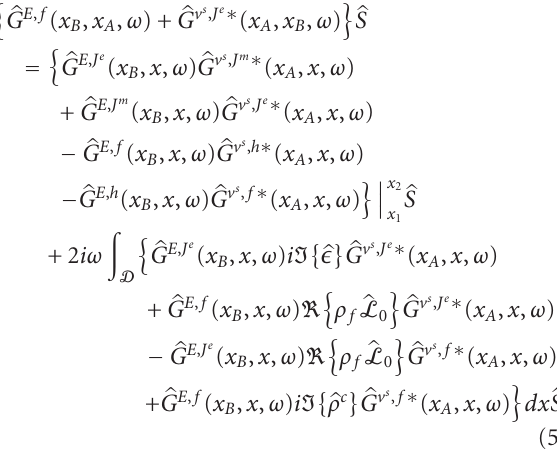
SH-TE Green’s matrix in 1D (50), using seismoelectric reciprocity theorems